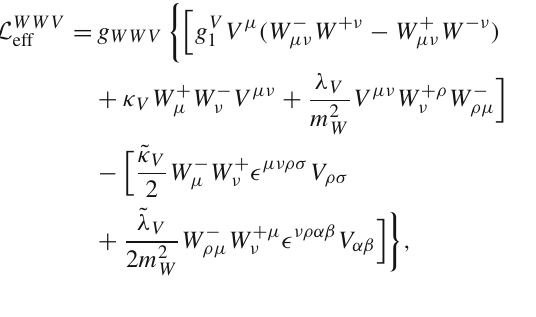
Fig. 20 Unfolded normalized distribution of the number of jets with p T > 30 GeV in the rapidity interval bounded by the two highest- p T jets in the inclusive fiducial region with M jj thresholds of 0.5 TeV ( top left ), 1.0 TeV ( top right ), 1.5 TeV ( bottom left ), and 2.0 TeV ( bottom